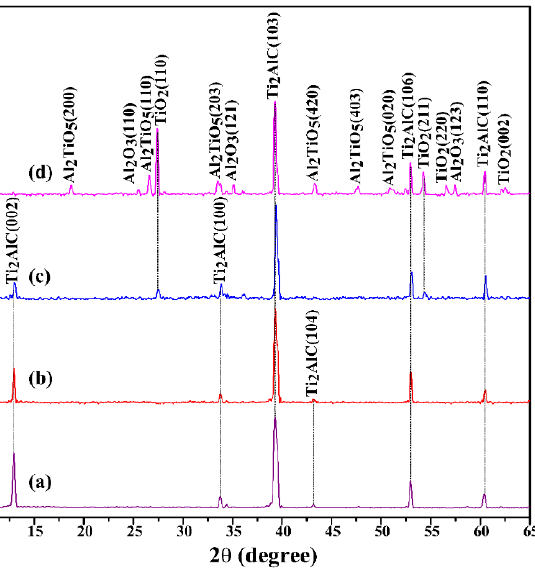
Figure 5. XRD patterns of Ti 2 AlC samples quenched in water at different temperatures: ( a ) 25 °C,